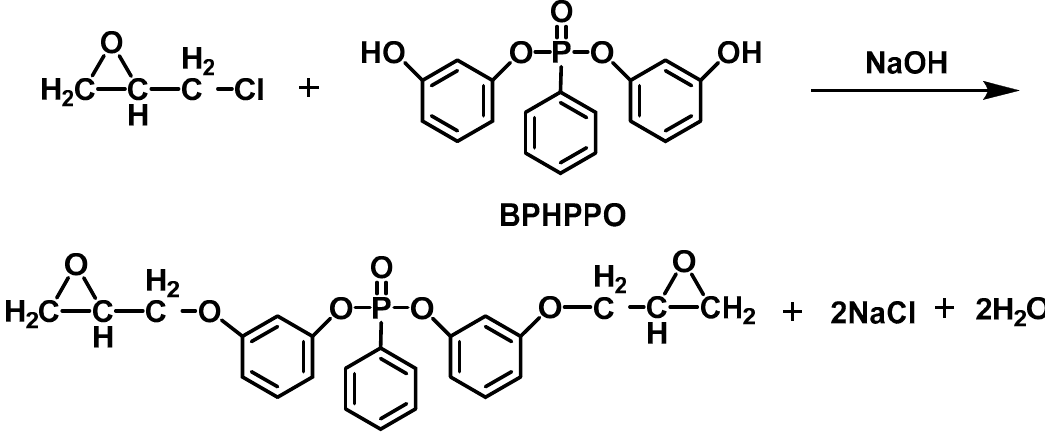
Figure 4. The synthesis of the BPHPPO-EP. Readapted with permission from Ref. [71], Copyright 2007, Elsevier Ltd.